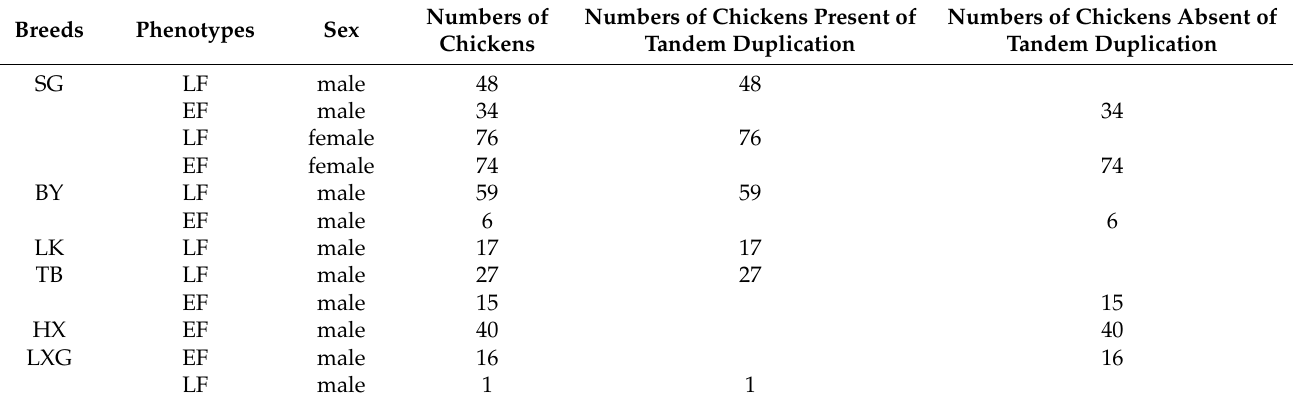
Table 3. The relationship between feathering rate and tandem